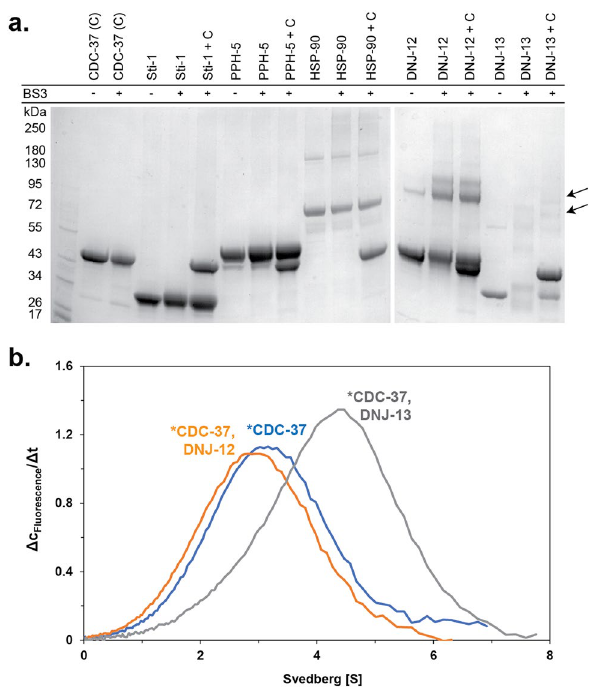
Figure 1. Systematic cofactor CDC-37 interactions. (a) Interaction of CDC-37 (C) with and without the crosslinking reagent BS3, as indicated together with the cofactors Sti1, PPH-5, HSP-90, DNJ-12 and DNJ-13. The upper arrowhead indicates the observed crosslinked CDC-37 monomer ·DNJ-13 dimer complex, whereas the lower arrowhead indicates a CDC-37 monomer ·DNJ-13 monomer complex. ( b) Sedimentation analysis of labeled CDC- 37 (*CDC-37) together with the J domain-containing proteins DNJ-12 and DNJ-13. OriginPro (Version 2018b) was utilized for generating the